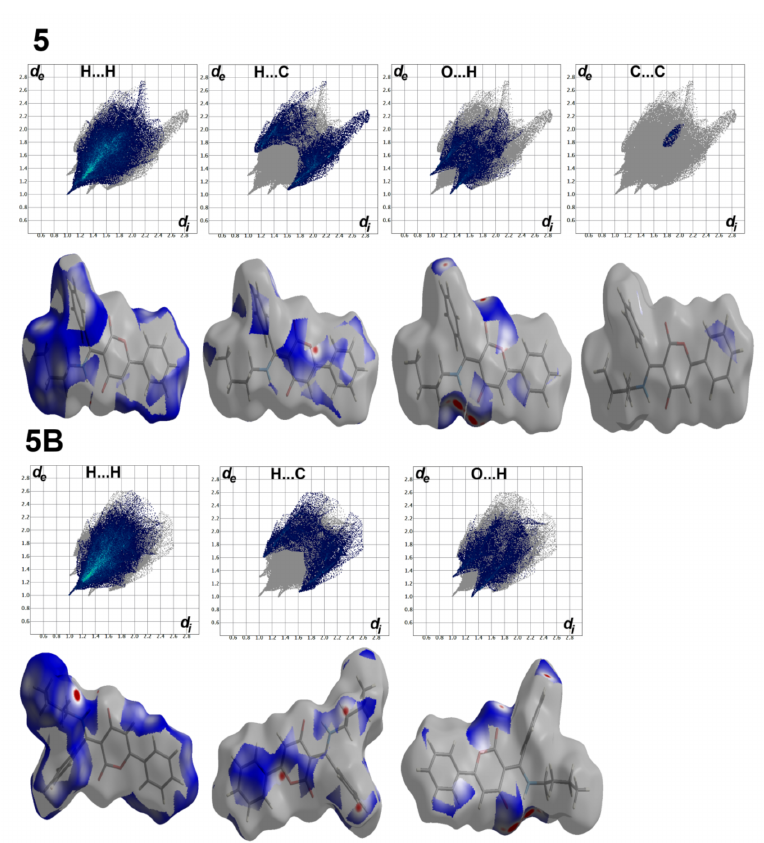
Figure 10. Decomposed fingerprint plots and d norm Hirshfeld surfaces of the most abundant interac- tions for both units in 5 . 5 and 5B refer to the atom numbering of molecular units in